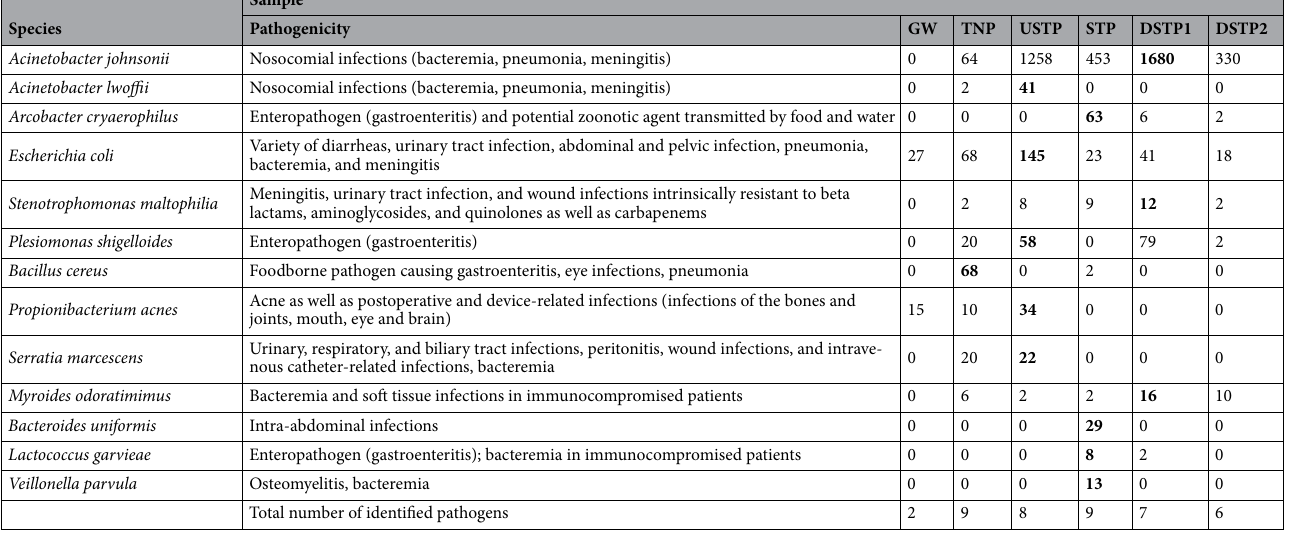
Table 1. Pathogenic species of bacteria and their number of reads detected in the water samples along the pollution gradient of the river in different sampling dates. Site abbreviations are as follows: GW